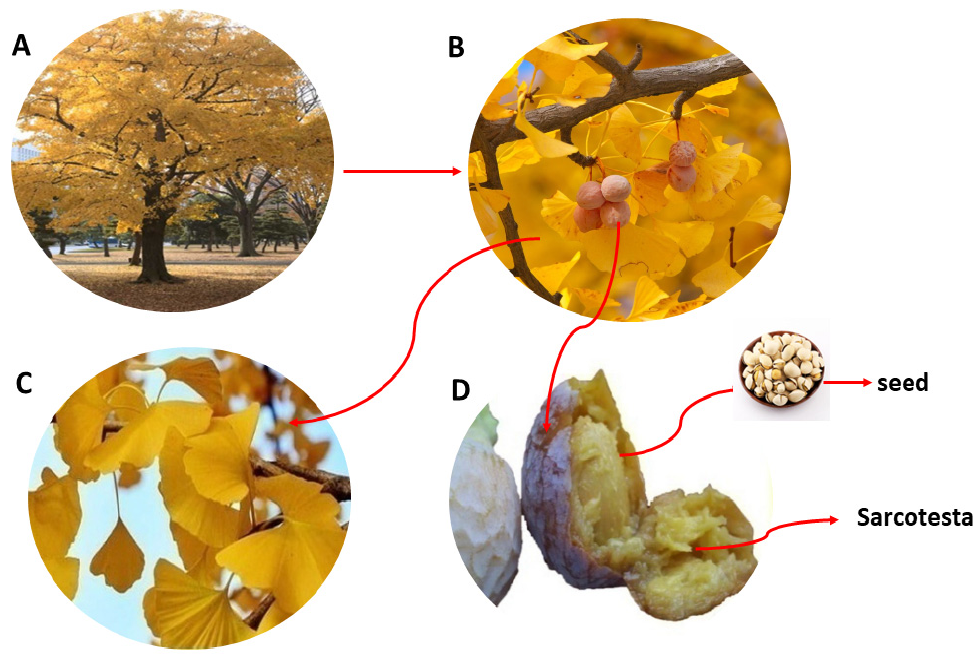
Figure 1. Ginkgo biloba tree and various parts: ( A ) tree, ( B ) fruit and leaves, ( C ) leaves, and ( D ) sar- cotesta and seed.